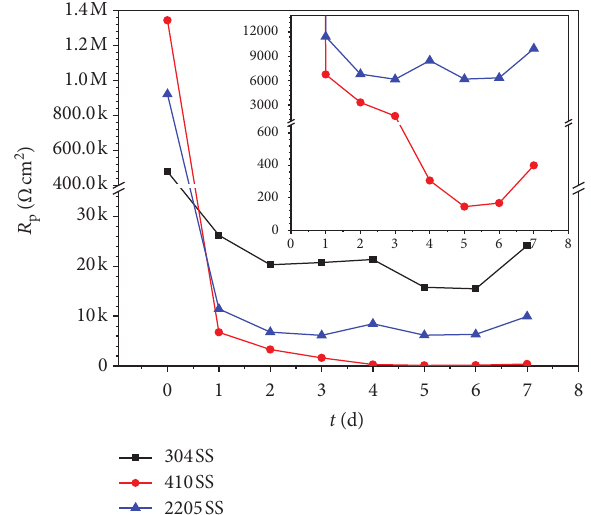
Figure 7: R p versus time during 7-day incubation.